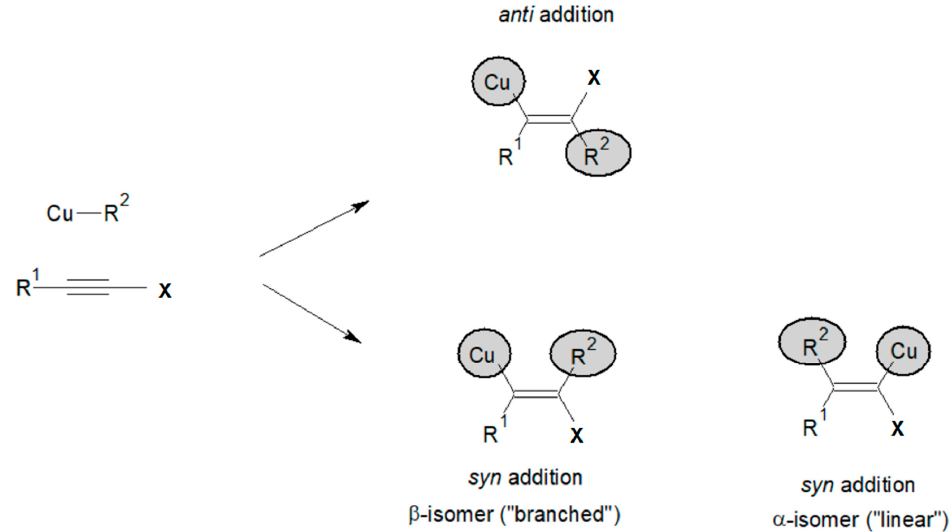
Figure 1. Reaction possibilities of Cu(I)alkyl with hetero-substituted alkynes (X =